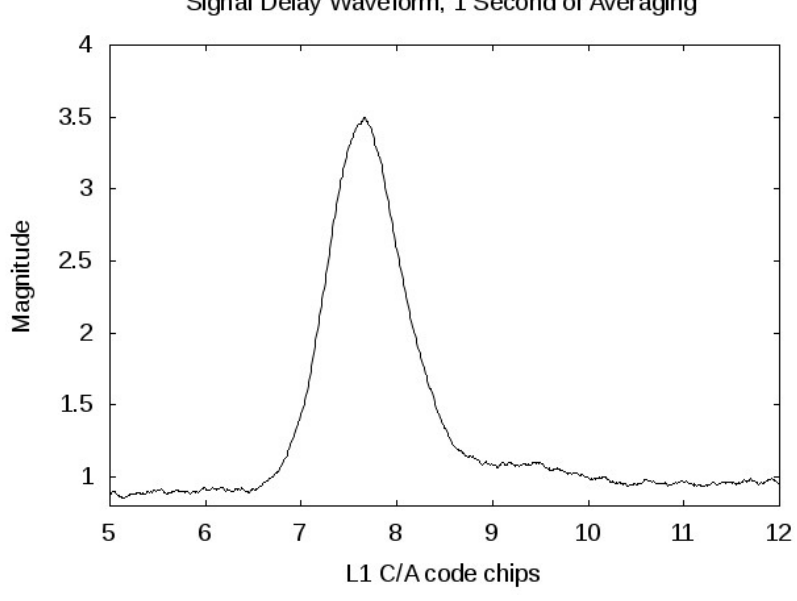
Figure 6. An example power delay for June 23rd 2005 signal. The x-axis is in GPS L1 C/A code chips and the y-axis is the total accumulated signal power after 1 second of non-coherent averaging. For an example of how chip delays map to the surface, see Figure